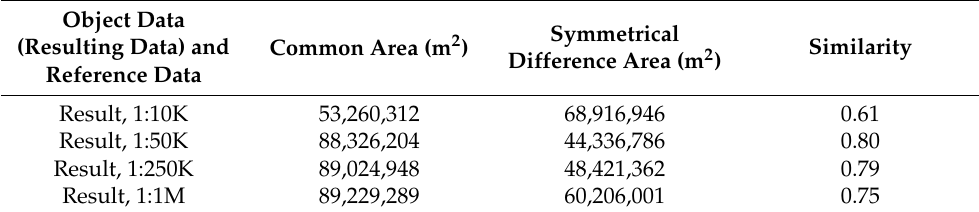
Table 4. The similarity between the resulting urban areas and the standard residential areas at varying scales.